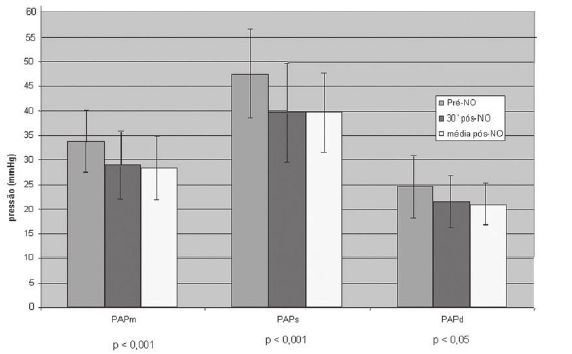
Fig. 1 - Variação geral da Pressão Arterial Pulmonar